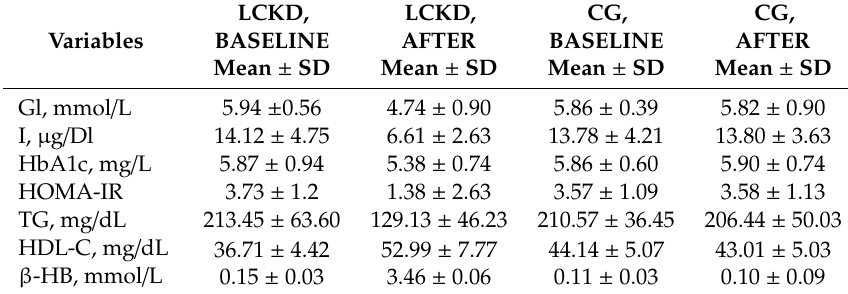
Table 2. Biochemical variables before and after the dietary